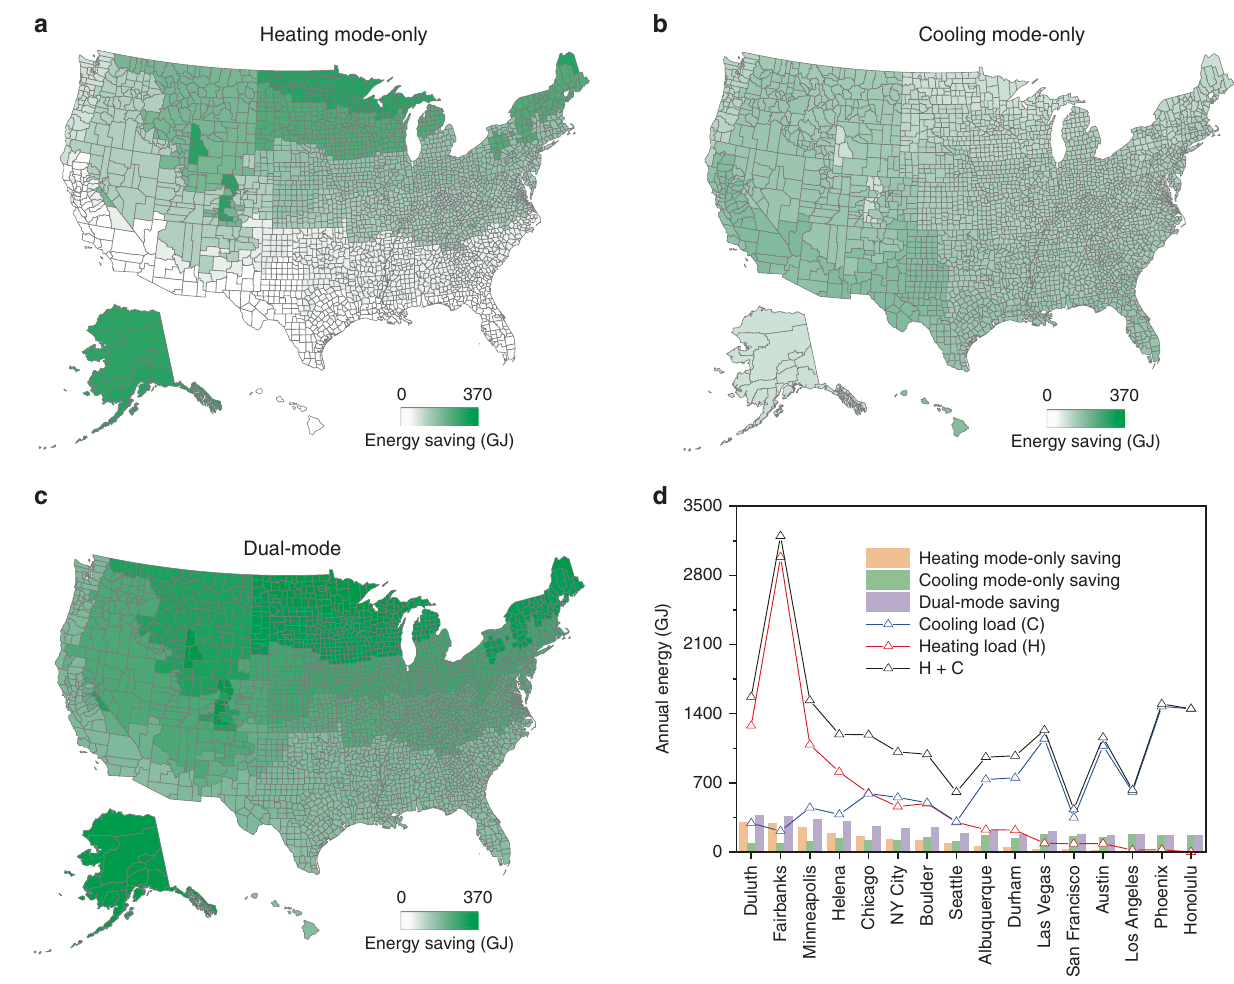
Fig. 5 Modeled annual energy saving of different energy-saving modes. Building energy-saving map for all U.S. climate zones with a only heating mode, b only cooling mode, and c dual-mode, d annual averaged energy saving at different modes and energy loads over different